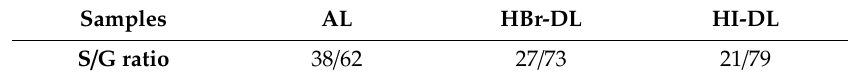
Table 4. Determination of S / G ratios for the AL and DLs by quantifying monomer unit type HSQC signals. Samples